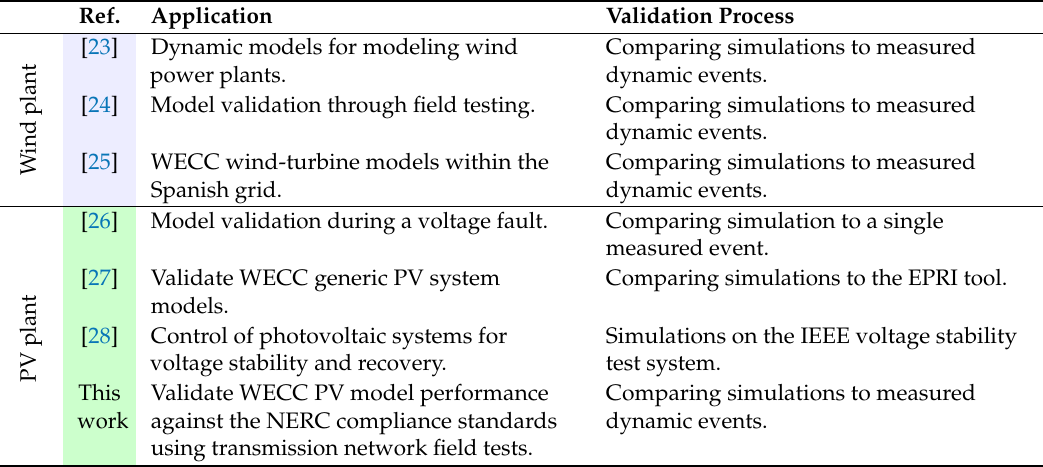
Table 1. Summary of the works focusing on WECC model